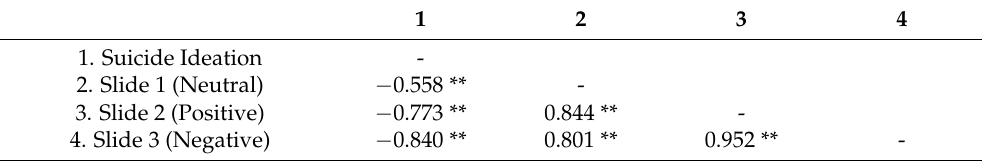
Table 6. Correlation